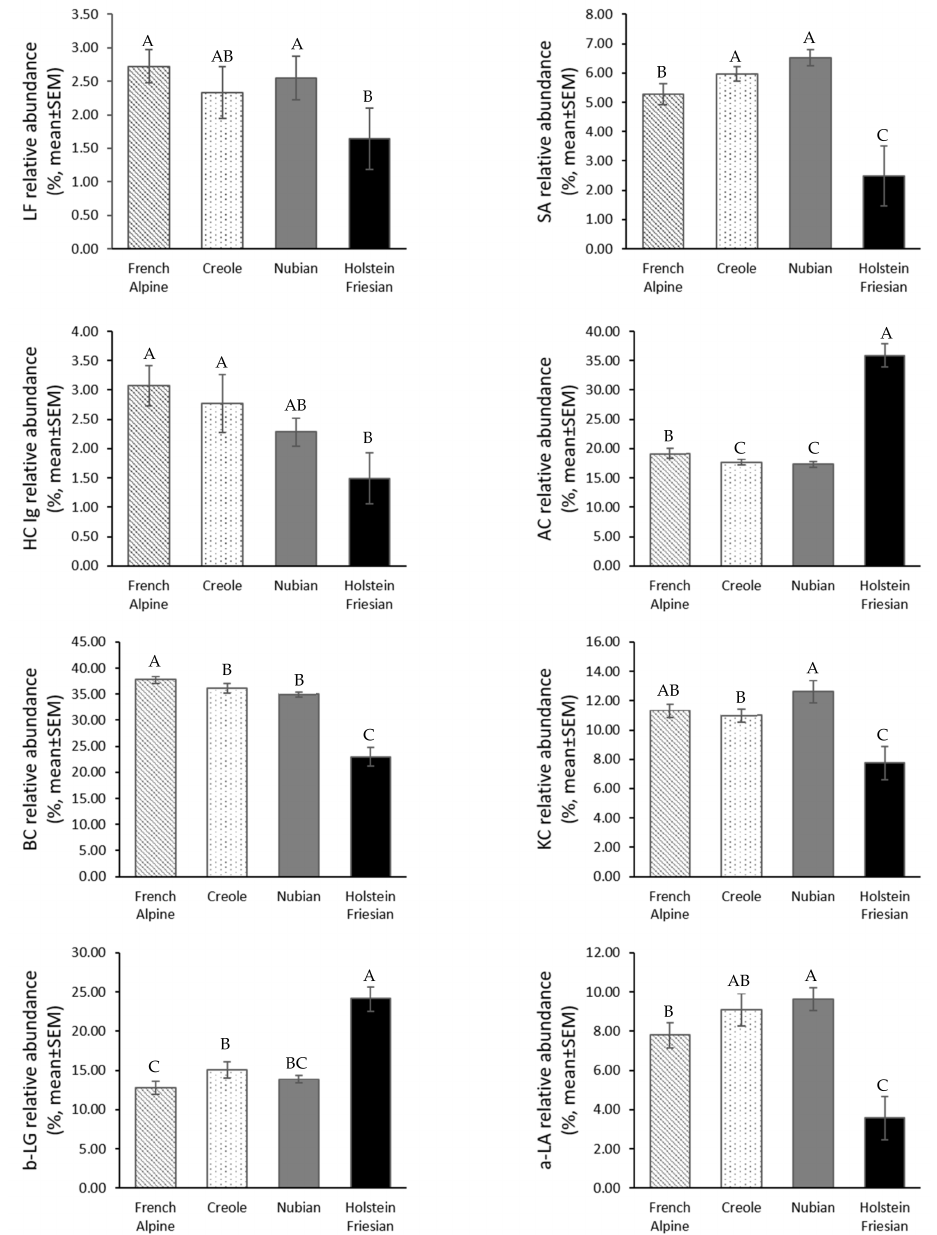
Figure 1. Mean relative abundance (%) ± SEM of proteins from French Alpine, Creole, and Nubian goat breeds, as well as from Holstein Friesian cows’ skimmed milk samples, resolved in 4–20% gradient polyacrylamide gel under denaturing and reducing conditions. Gels were stained with colloidal Coomassie blue G-250 and documented using the GelDoc EZ imager (Bio-Rad). Data were recorded and integrated as optical density from gel band peak areas using Image Lab 5.0